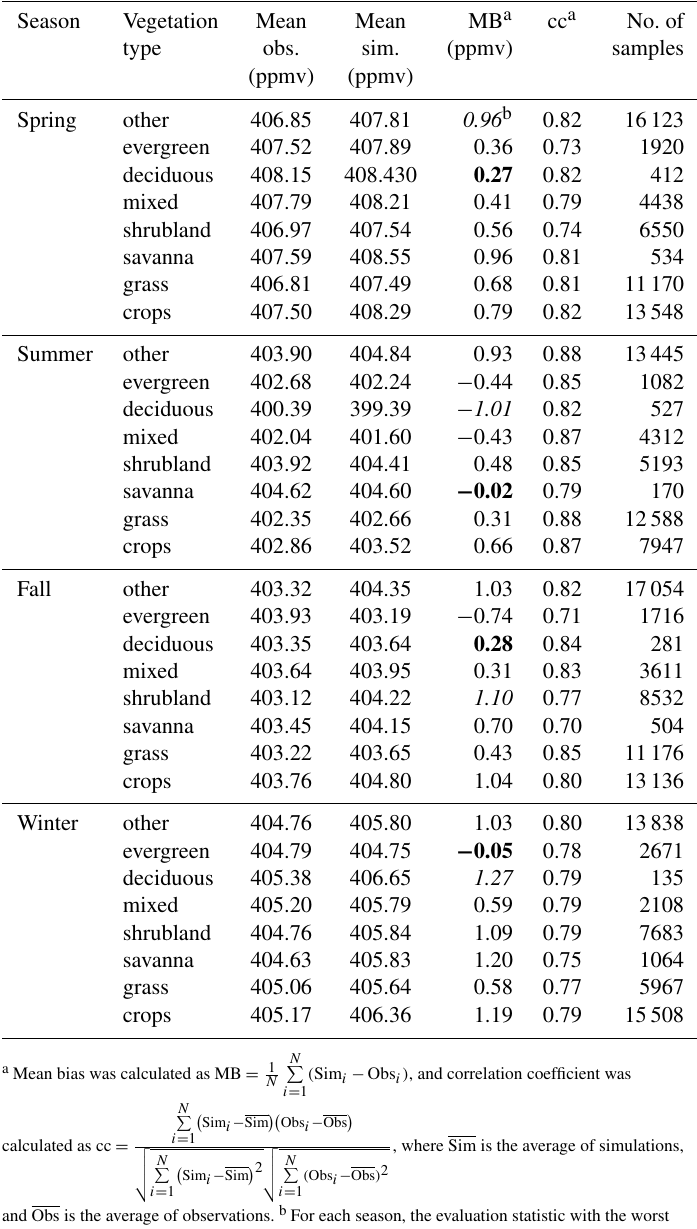
Table 1. Evaluation statistics a for WRF-Chem 20km grid simulation against the OCO-2 satellite product at daily